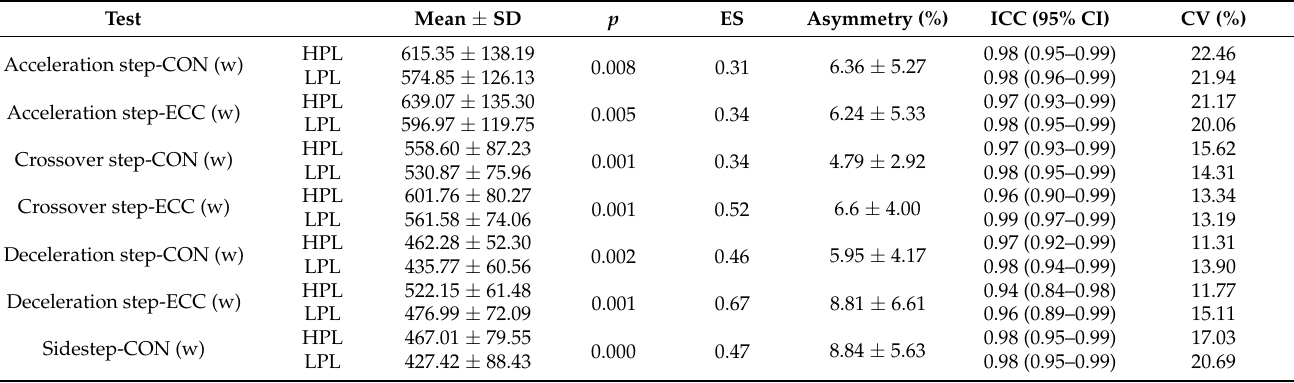
Table 1. Mean test scores, effect sizes, inter-limb asymmetry values, and test reliability